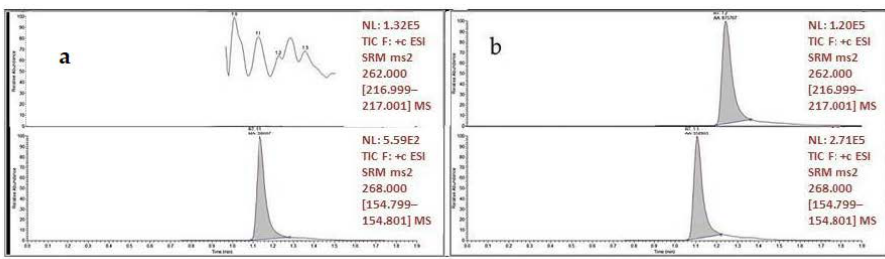
Figure 3. Blank plasma ( a ) vs. patient plasma under CNB treatment and concomitant assumption of other ASMs ( b ). In panel ( a , b ), lower chromatograms showing the internal standard peak.